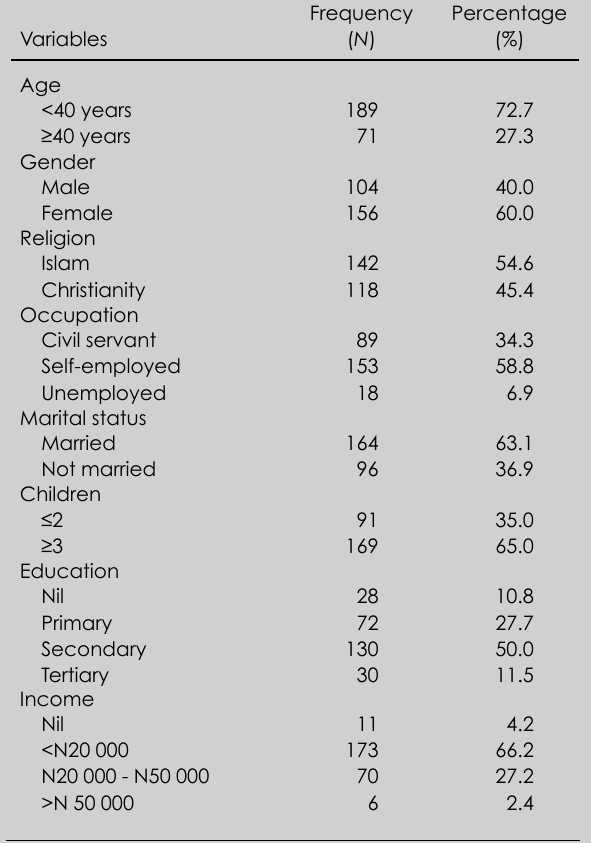
Table I. Socio-demographic characteristics of the subjects